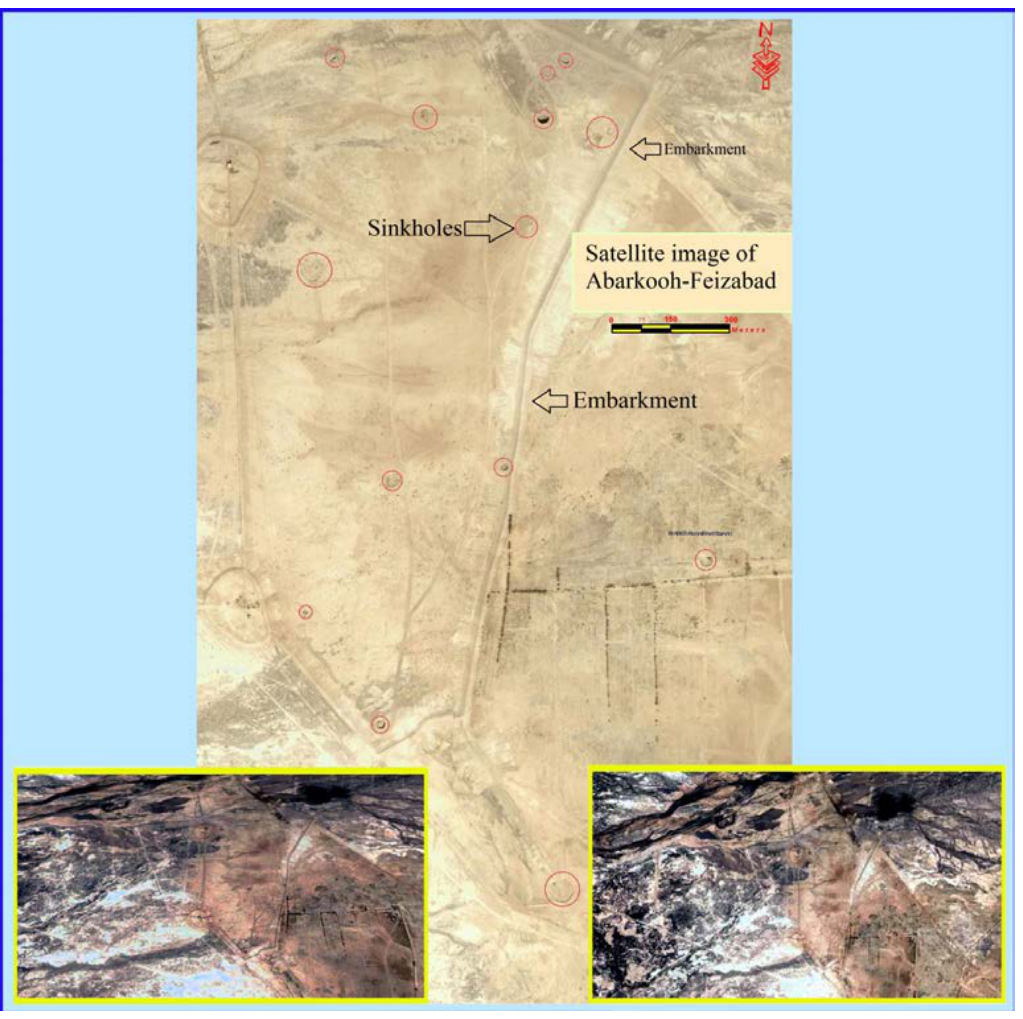
Figure 9. Satellite images of some of the sinkholes near Feizabad.